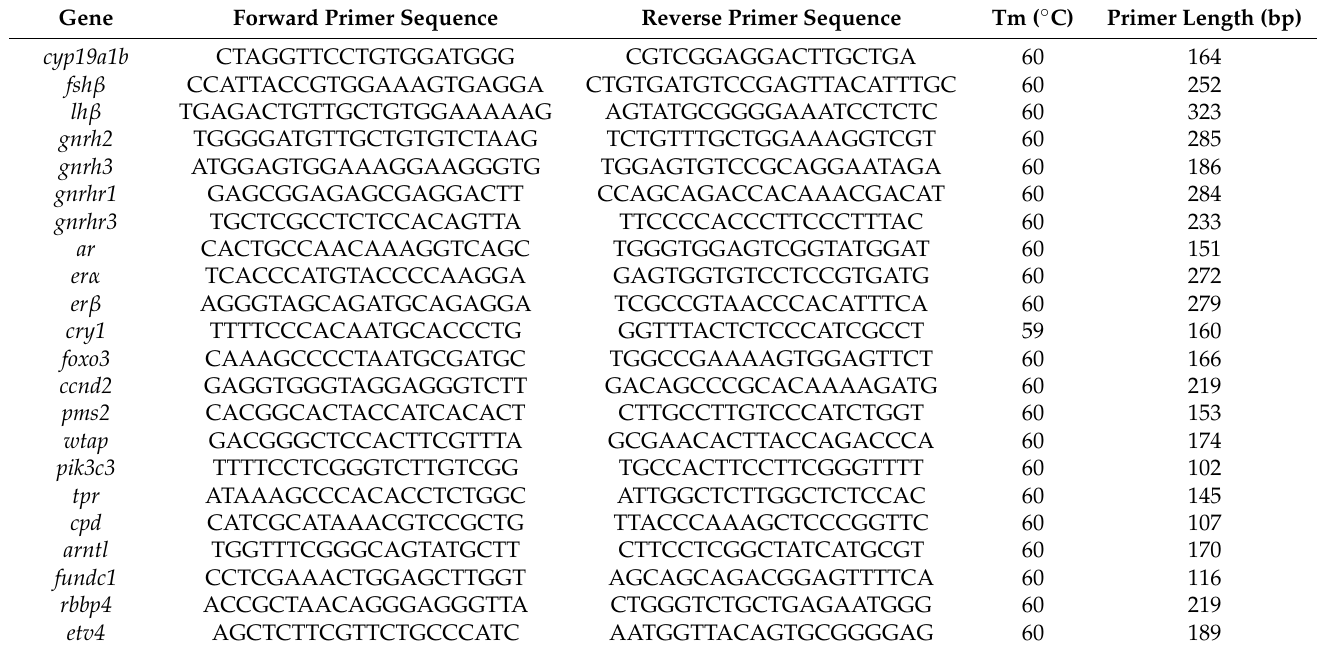
Table 2. Primer sequences of